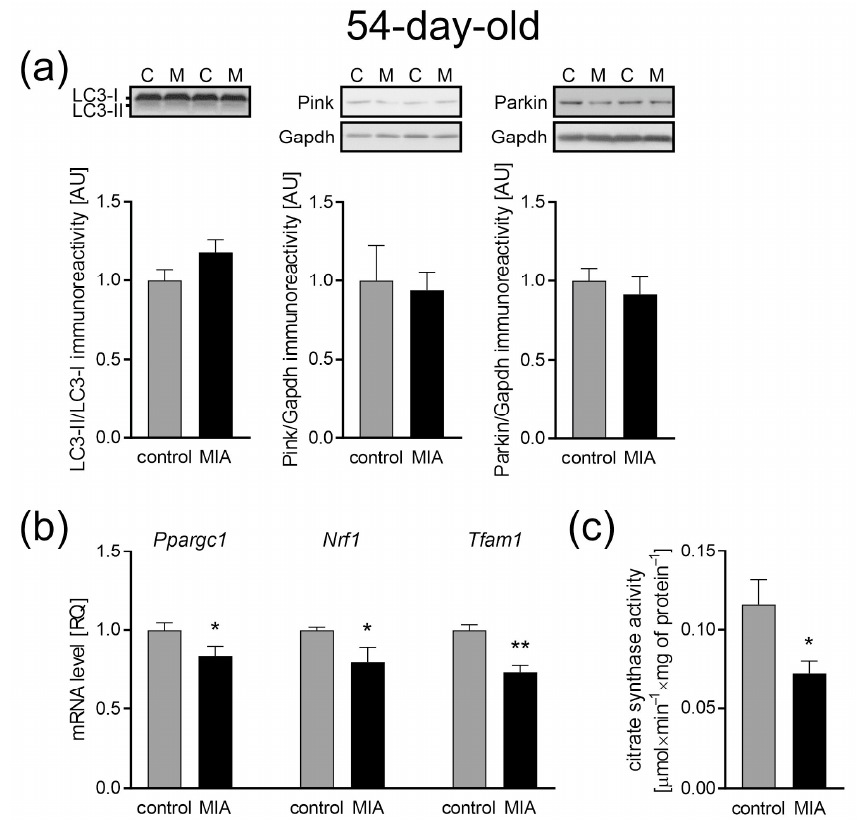
Figure 10. The effect of MIA on the mitochondria content, biogenesis, and autophagy processes in the brain of a 54-day-old MIA offspring rats. ( a ) The level of immunoreactivity of LC3 (n = 6 and 7), Pink (n = 6), and Parkin (n = 7 and 5) was analyzed using the Western blot method. Densitometric analysis was performed using normalization to immunoreactivity of Gapdh. Representative immunoblots are presented. ( b ) The level of mRNA for main biogenesis genes, Ppargc1 (n = 5 and 4), Nrf1 (n = 4), and Tfam1 (n = 4), was measured by real-time PCR and with Actb as a reference gene. ( c ) The mitochondria content was measured by the activity of the citrate synthase (n = 7 and 6). Data represent the mean value ± S.E.M. and were analyzed using Student’s t -test, * p < 0.05, ** p < 0.01, compared with the control group.